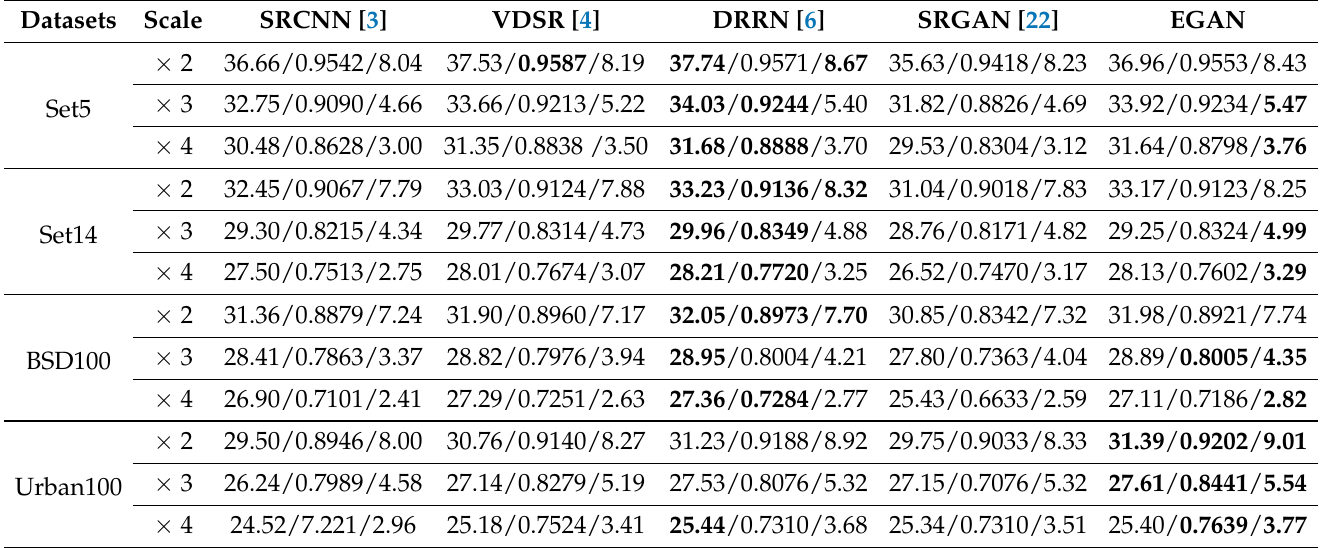
Table 4. Benchmark results. Average PSNR, SSIM, and IFC on the datasets for comparison, increasing by factors of 2, 3, and 4. Bold fonts represent the best results for each